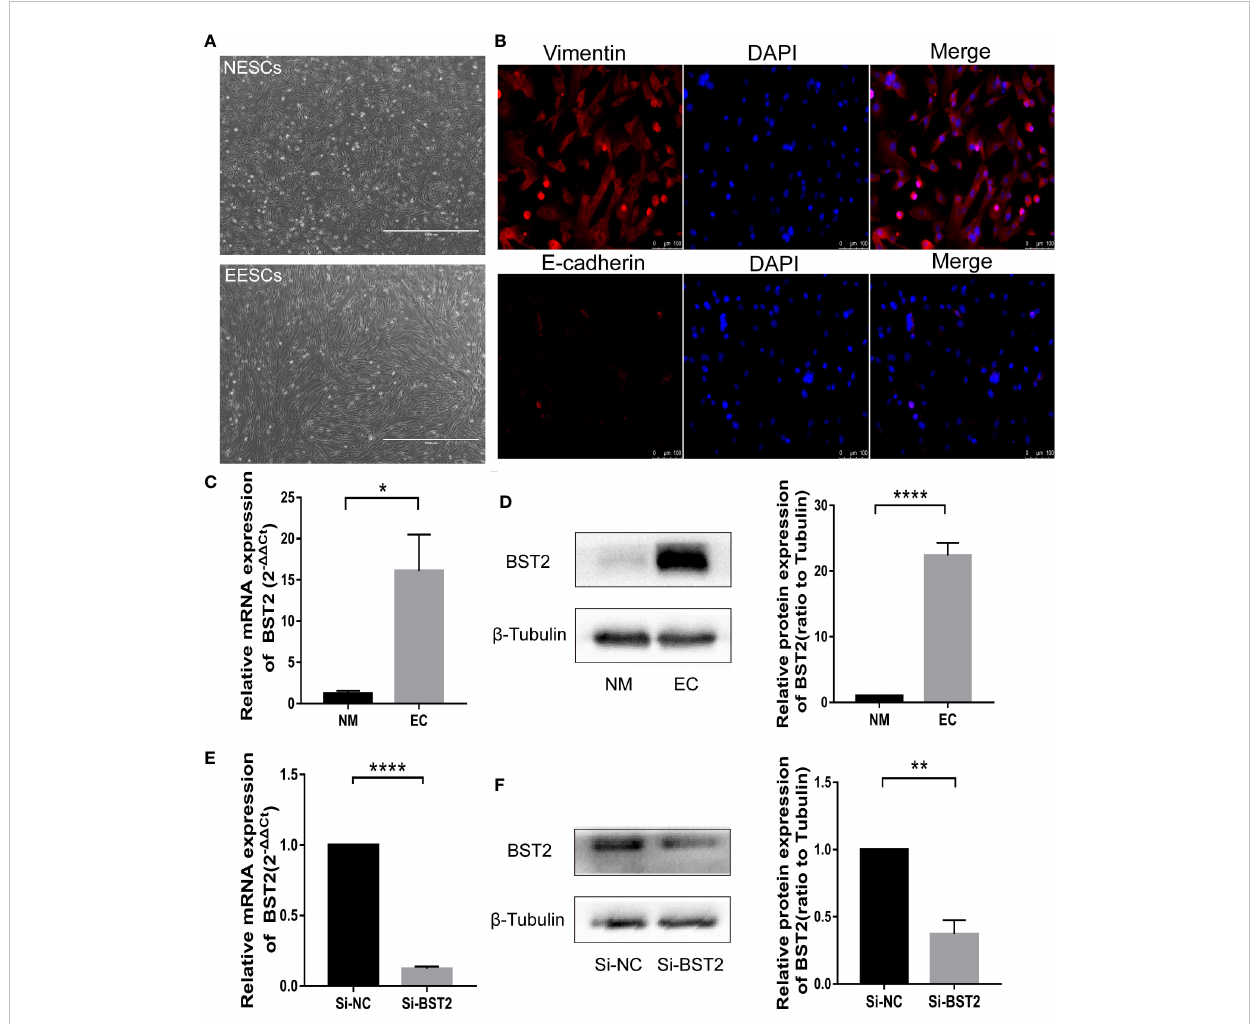
FIGURE 2 Identi fi cation of endometrial stromal cells and BST2 expression at the cellular level. (A, B) , The identi fi cation of endometrial stromal cells on the morphology (A) and Immuno fl uorescence (B) . (C, D) , BST2 mRNA (C) and protein (D) expression at the cellular level. (E, F) , Identi fi cation of the transfection ef fi ciency of Si-BST2 at the mRNA (E) and protein (F) levels. *p < 0.05; **p < 0.01; ****p <